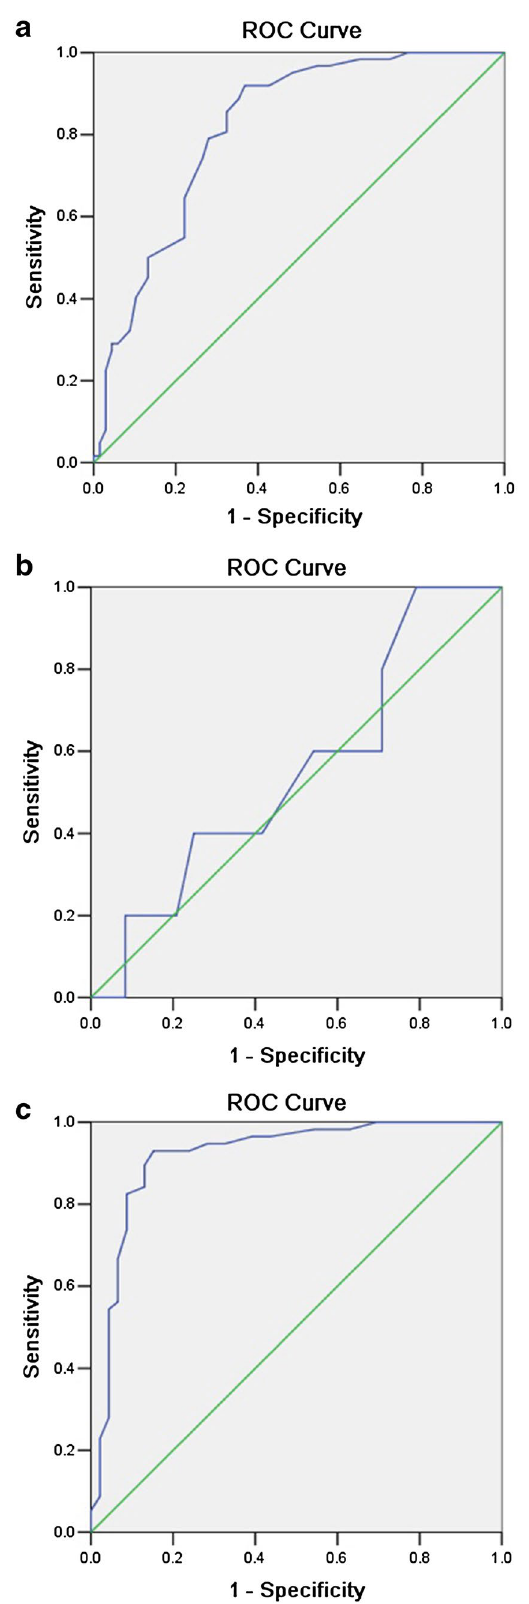
Fig. 4 ROC analysis of dIVC for the detection of fluid responsiveness. a Area-under-the-curve (AUC) of dIVC for the detection of fluid responsiveness in all patients 0.815 (95% CI 0.742–0.889; p < 0.001). b In ILVD patients, the AUC was only 0.550 (95% CI 0.283–0.817; p 0.729). = c In NLVF patients, the ROC analysis revealed an AUC of 0.918 (95% CI 0.858–0.978; p < 0.001), which was statistically significant compared with the AUC derived from all patients, p 0.033. ILVD isolated left = ventricular systolic dysfunction, NLVF normal left ventricular function; dIVC inferior vena cava distensibility index